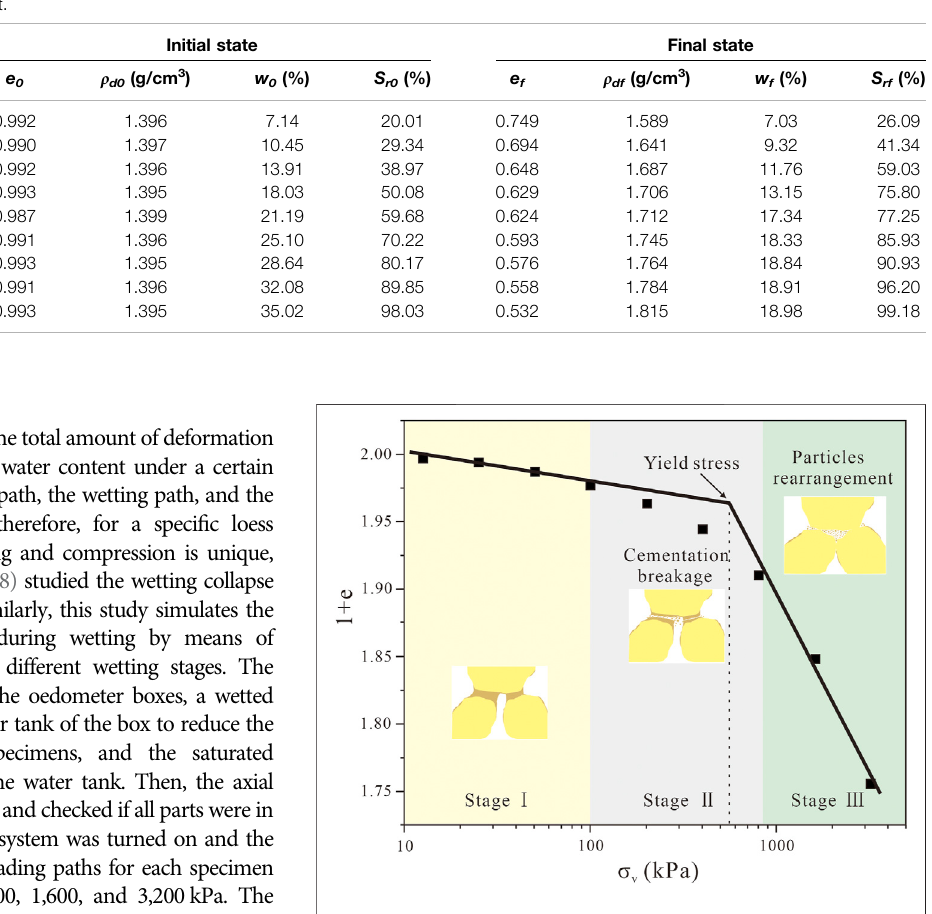
FIGURE 3 | Schematic diagram of the loess compression evolution